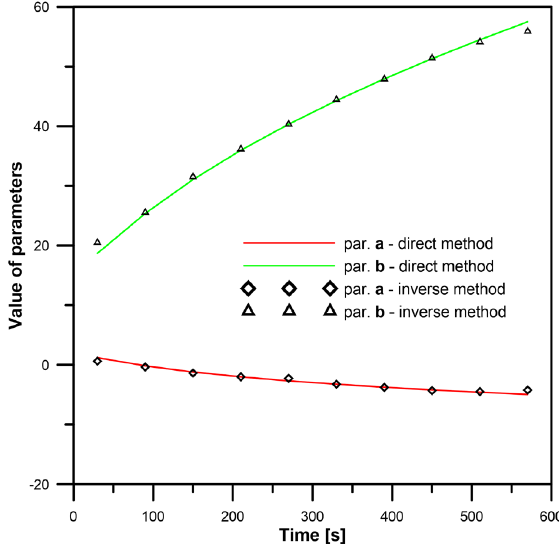
Figure 7. Comparison between exact parameters and parameters calculated by the inverse method based on “noisy measured data”.